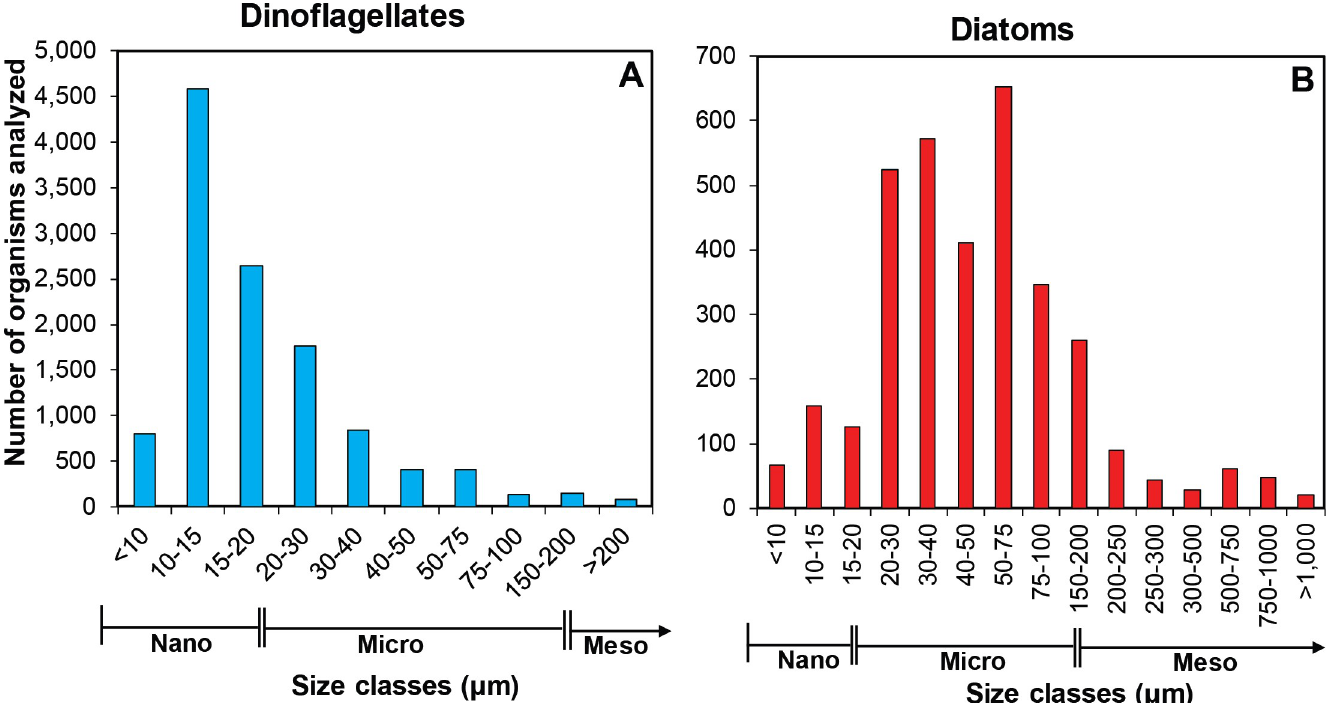
Fig 2. Distribution of the greatest linear dimension (GLD, μ m) of two phytoplankton groups. Frequency histograms of cell size indicated by the GLD ( μ m) measured in genera of (A) dinoflagellates and (B) diatoms. Nano-, micro-, and meso-size categories are displayed at the X-axis. Note the larger bin numbers used for the meso-size class in